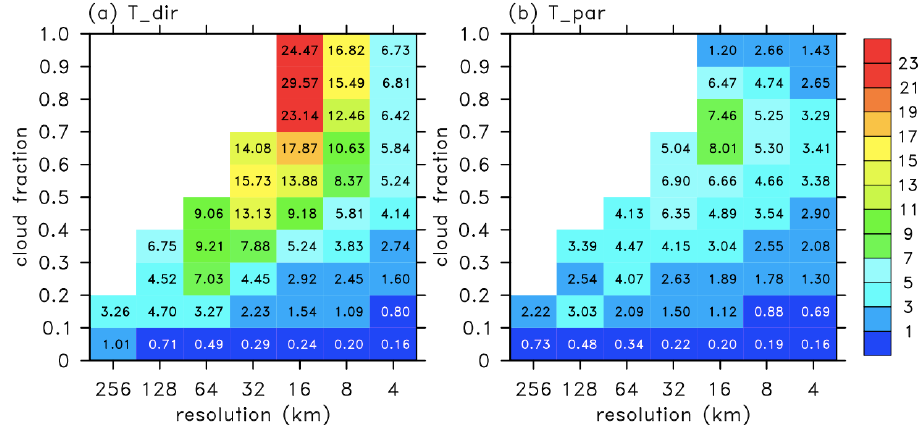
Figure 7. Subdomain size and convective cloud fraction dependency of eddy transport (m/s · K) of moist static energy from ( a ) Equation (3) and ( b ) Equation (5) at 500 hPa.